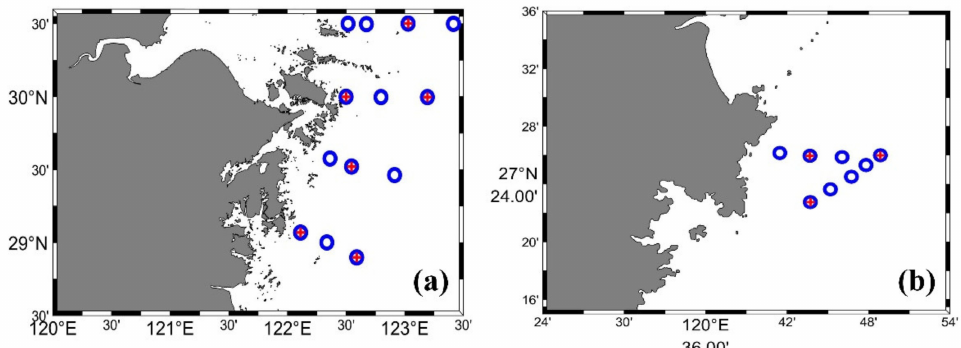
Figure 4. All 21 Stations (blue circles) at the East China Sea (ESC) including 9 stations for microscopic imaging (red plus). ( a ) The observation in May 2021. ( b ) The observation in August 2021.The gray part represents the land and the white part represents the